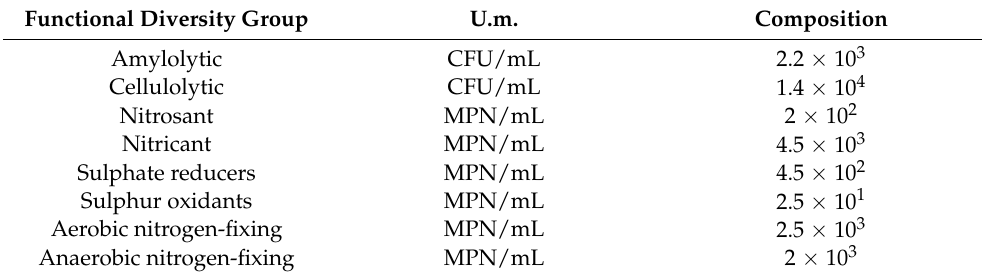
Table 3. Microbiological composition of vermiwash. CFU, colony forming unit; MPN, most probable